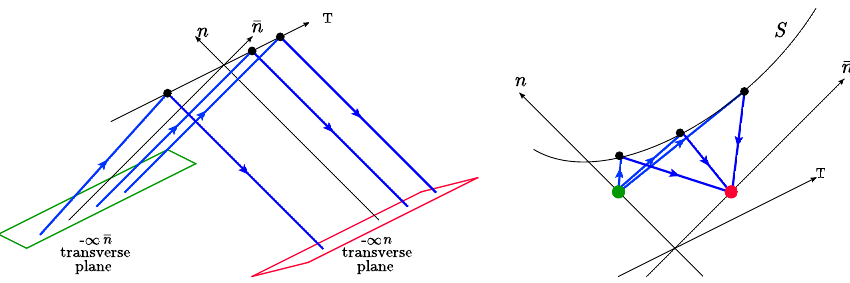
Figure 5 . The shape of the MPS soft factor before (left) and after (right) the transformation C n (cid:22) n (with restrictions (5.5)). The transverse planes at light-cone in(cid:12)nities transforms to the points (the correspondence is shown by the same color). The traverse plane at the light-cone origin transforms into the plane S formed by intersection of light-cones that are set in the green and red